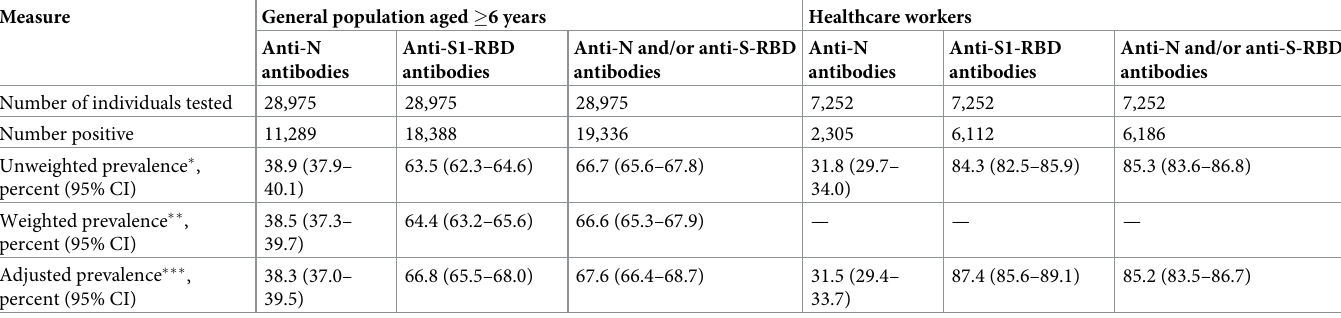
Table 2. Seroprevalence (percent) of IgG antibodies against SARS-CoV-2, India, June–July